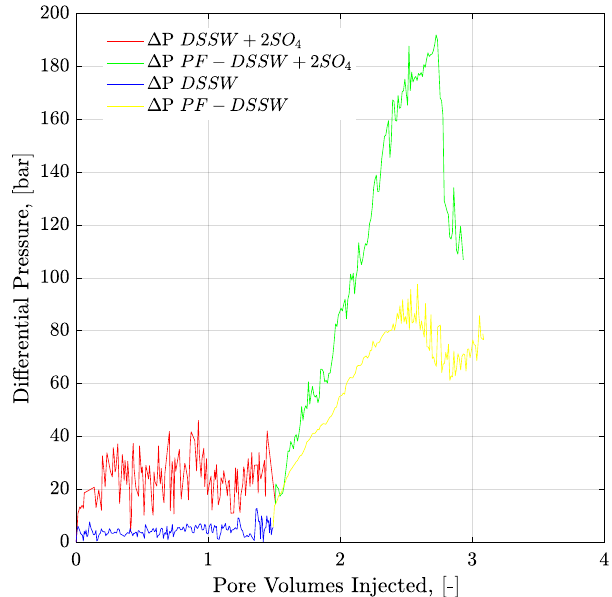
Figure 17. Pressure drop versus PV injected for complex-wet micromodel. PF1 (polymer half to the oil viscosity) and PF2 (polymer equal to the oil viscosity) flooding after the brine flood in secondary mode. ∆ P SSW + 2SO 4 represents the pressure drop for synthetic seawater with doubled amount of sulfate. ∆ P PF1-SSW + 2SO 4 represents the pressure drop of polymer injection having viscosity half to the oil and ∆ P PF2-SSW + 2SO 4 shows pressure drop of polymer injection having viscosity equal to the oil.